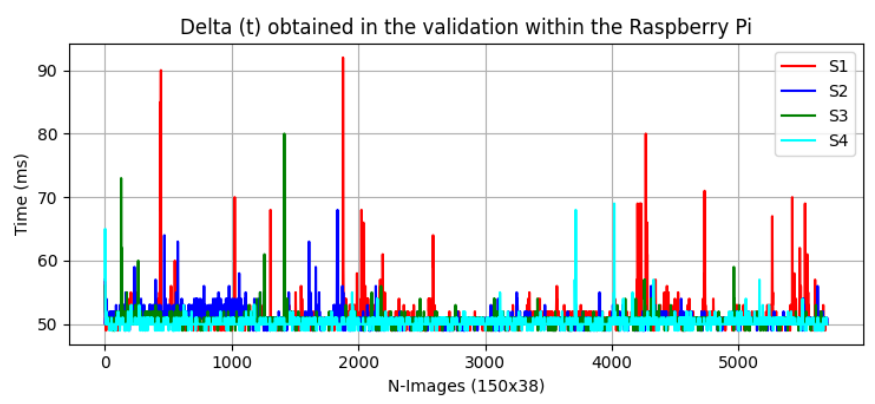
Figure 7. Delta (t) obtained in the validation within the Raspberry